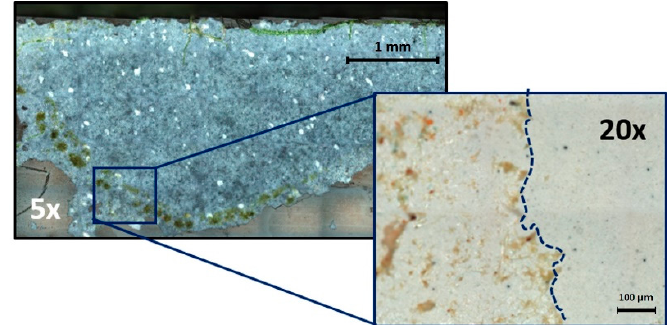
Figure 8. Optical images at 5× and 20× of the immersed coating. The photos were taken in a part of coating that was under a bubble. In particular, the 20× image was taken on the edge of the bubble. To understand if the coating was intact under the bubble, SEM observation was performed. Figure 9 was taken on a bubble edge, distinguishing two different zones: on the left part of the image, where the bubble was present, diatoms and biomaterial attachment were prevented, while they were present on the right ‐ lower side of the picture.